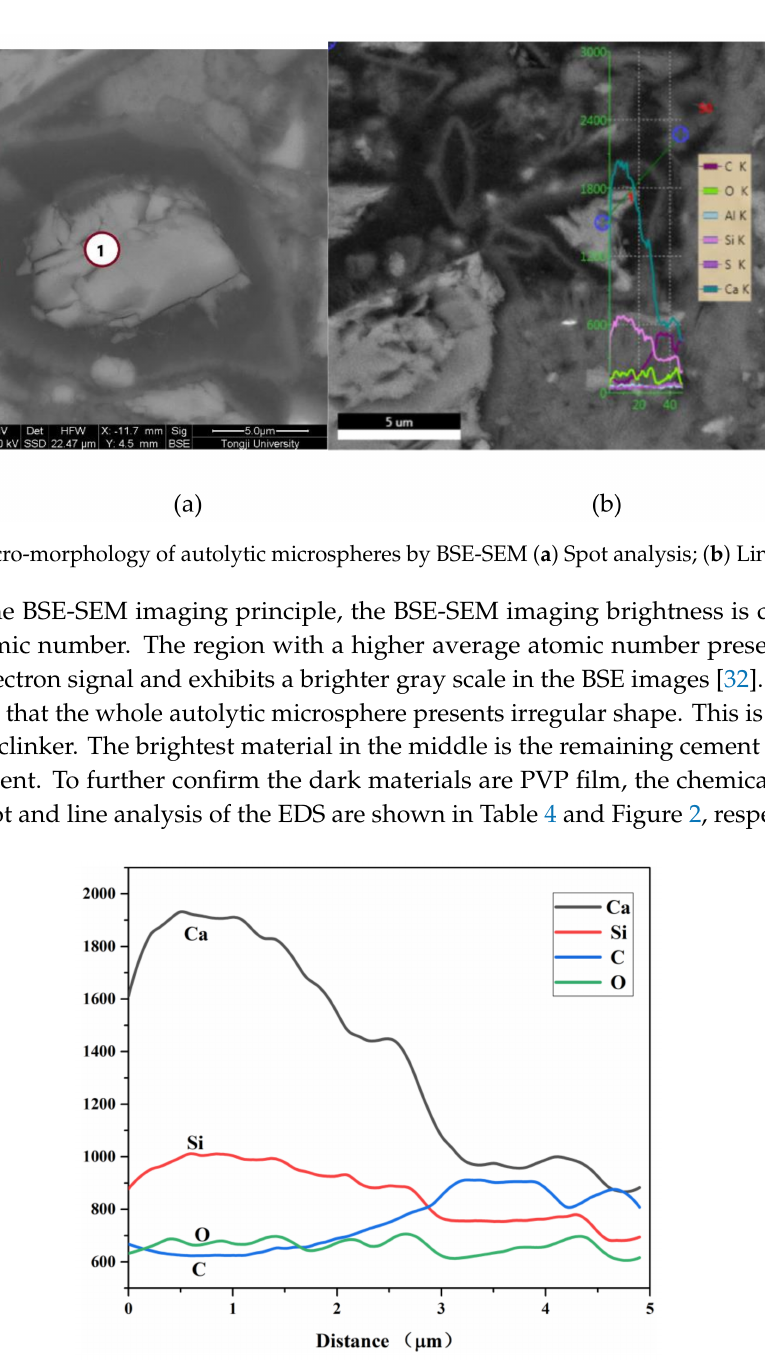
Figure 2. Energy dispersive spectrometer (EDS) line analysis results of autolytic